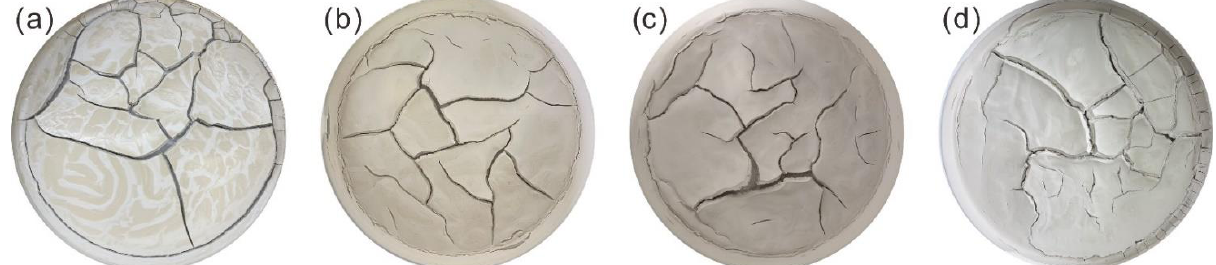
Figure 10. Desiccation crack morphology under different Q:F (Q:F refers to the ratio of quartz to feldspar minerals.) conditions. S8, S9, S10, and S11 are shown in the figure from left to right. ( a ) 20% quartz, 80% feldspar. ( b ) 40% quartz, 60% feldspar. ( c ) 60% quartz, 40% feldspar. ( d ) 80% quartz, 20% feldspar. (The diameter of the sample is 24 cm.).